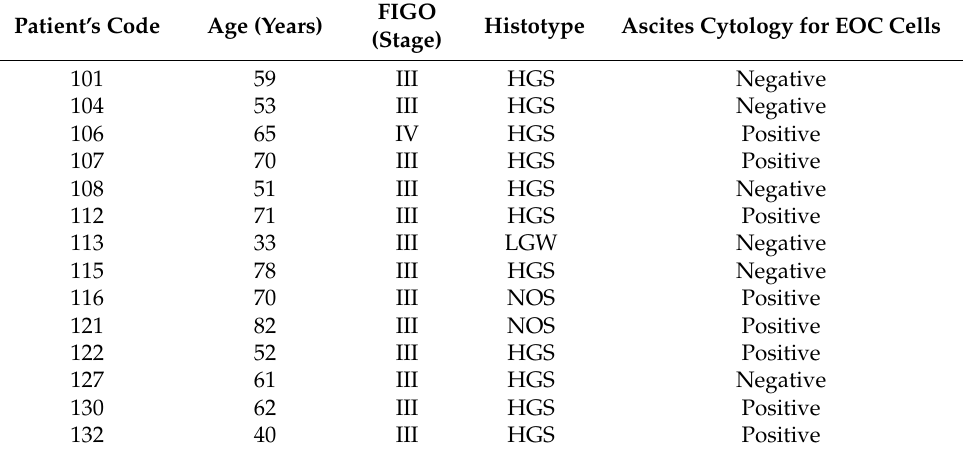
Table 1. Characteristics of epithelial ovarian cancer (EOC) patients included in the study at the time of ascites sampling. Staging classification followed FIGO Committee on Gynecologic Oncology guidelines. FIGO Histotype Ascites Cytology for EOC Patient’s Code Age (Years) (Stage)